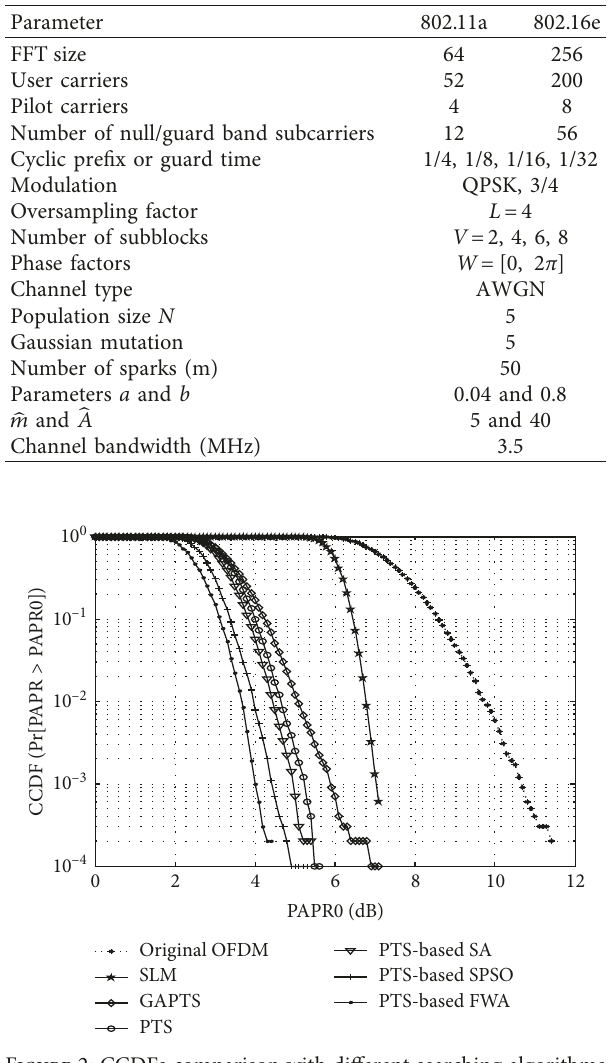
Table 1: Simulation